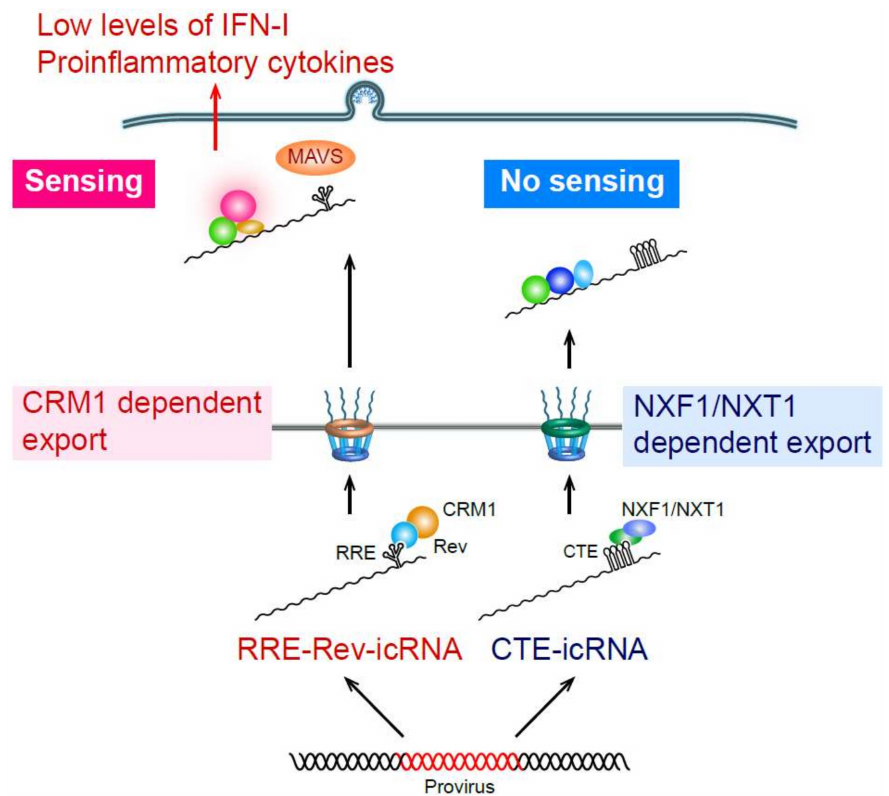
Figure 2. HIV icRNA-induced inflammation in macrophages. HIV icRNA exported from nucleus to cytosol by the Rev–CRM1-dependent pathway (RRE–Rev-icRNA) is sensed by a yet-to-be-identified RNA sensor, triggering ISG and IFN-I expression and pro-inflammatory cytokine production via MAVS. In contrast, cytosolic HIV icRNA exported by the NXF1 / NXT1-dependent pathway (CTE-icRNA) does not result in ISG expression and IFN-I